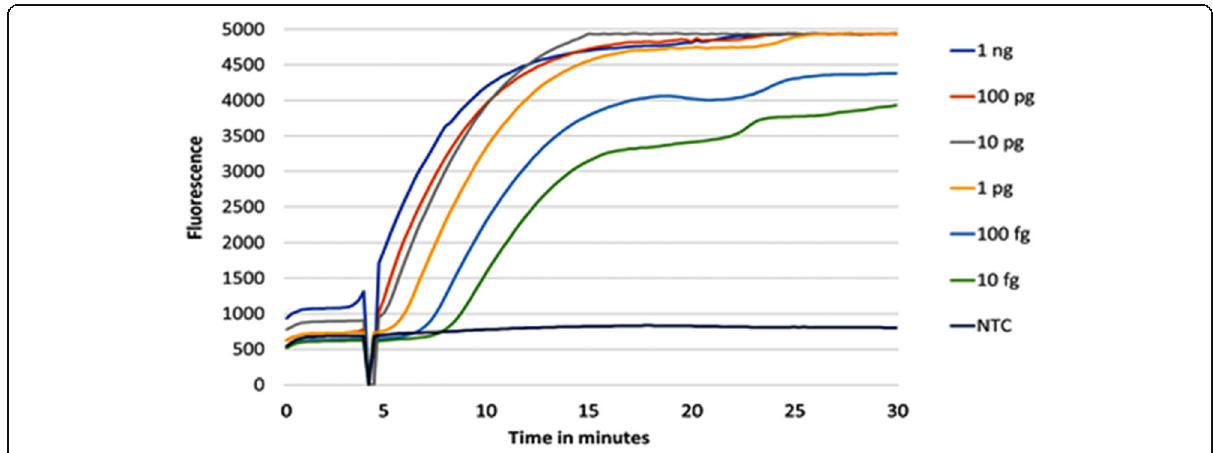
Fig. 3 Amplification curves of RPA assay for concentrations ranging from 1 ng to 10 fg purified genomic DNA of P.